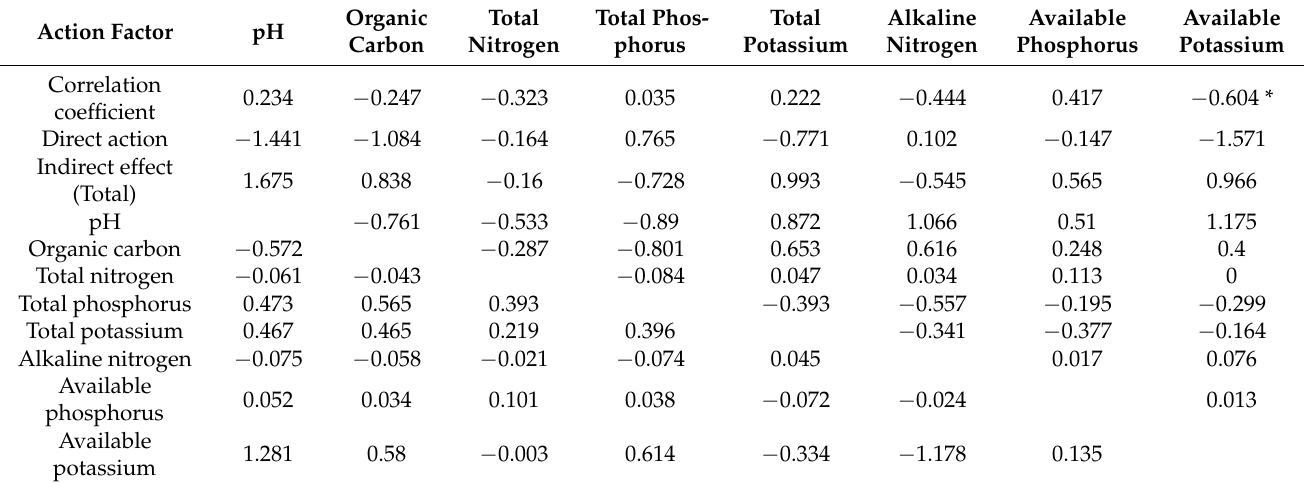
Table 3. Path coefficients of the physical and chemical properties of the soil surface for the potassium content in the new shoots of